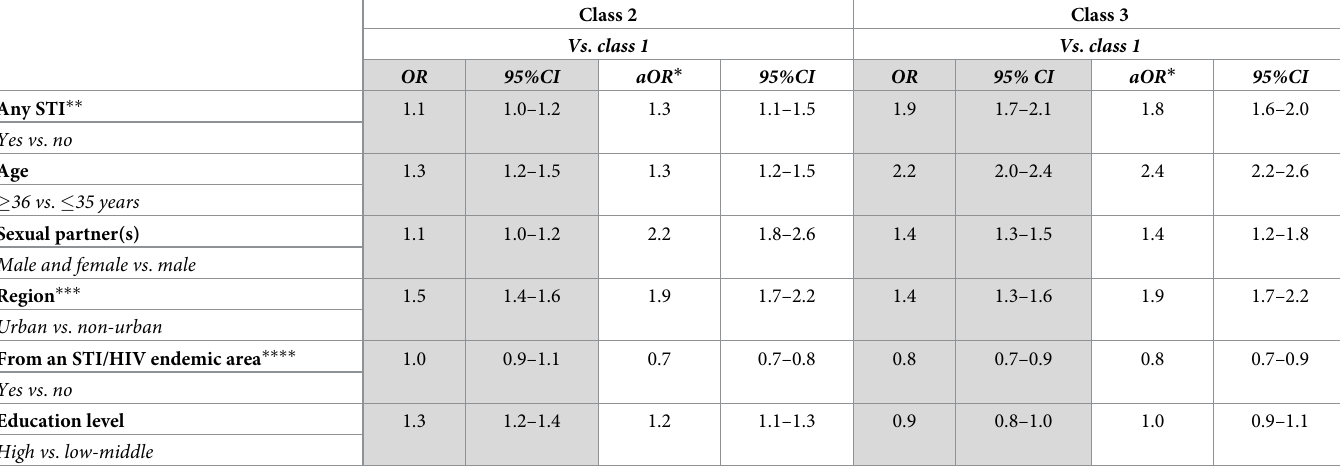
Table 3. Association between class membership and various factors (LCA model with covariates) comparing classes 2 and 3 to class